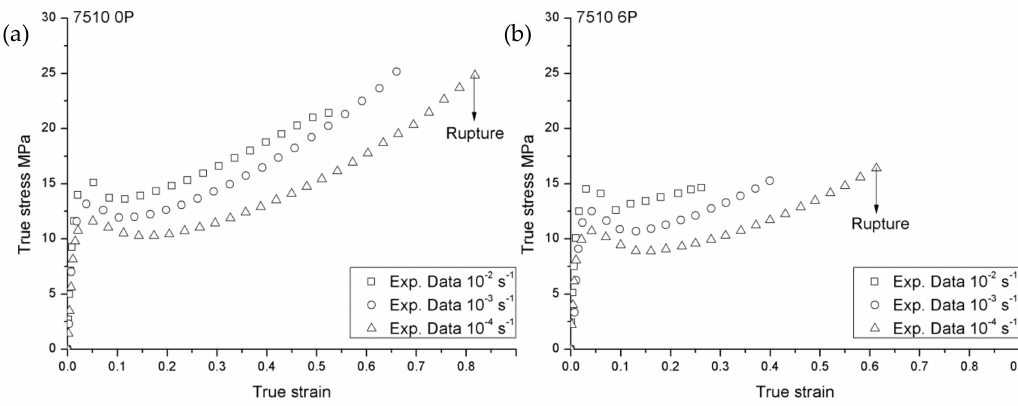
Figure 2. True stress vs. true strain responses of 7510 ( a )0P and ( b ) 6P at three di ff erent strain